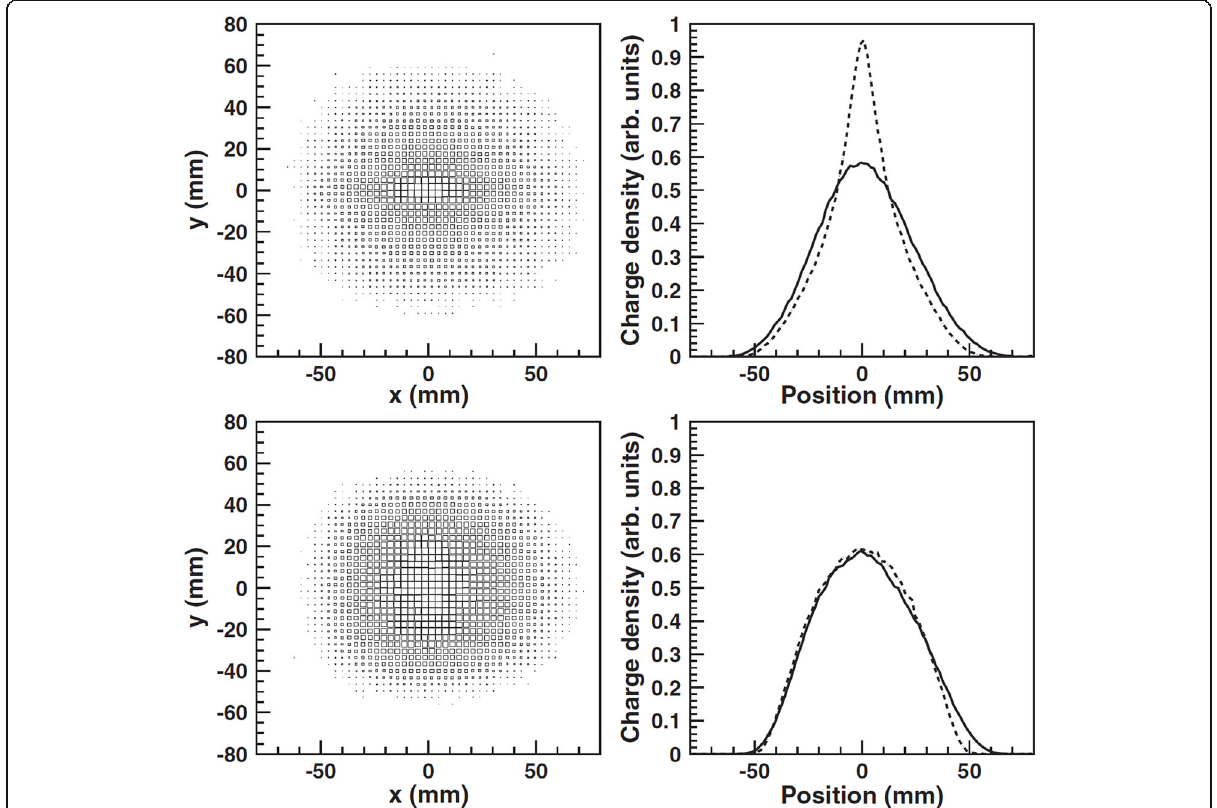
Fig. 14 Simulation results for the J-PARC RCS; particle distributions on the two-dimensional transverse plane ( x , y ) at the end of injection, obtained without (upper) and with (lower) transverse painting, and their projections onto the x (solid curves) and y (dashed curves) axes [21]